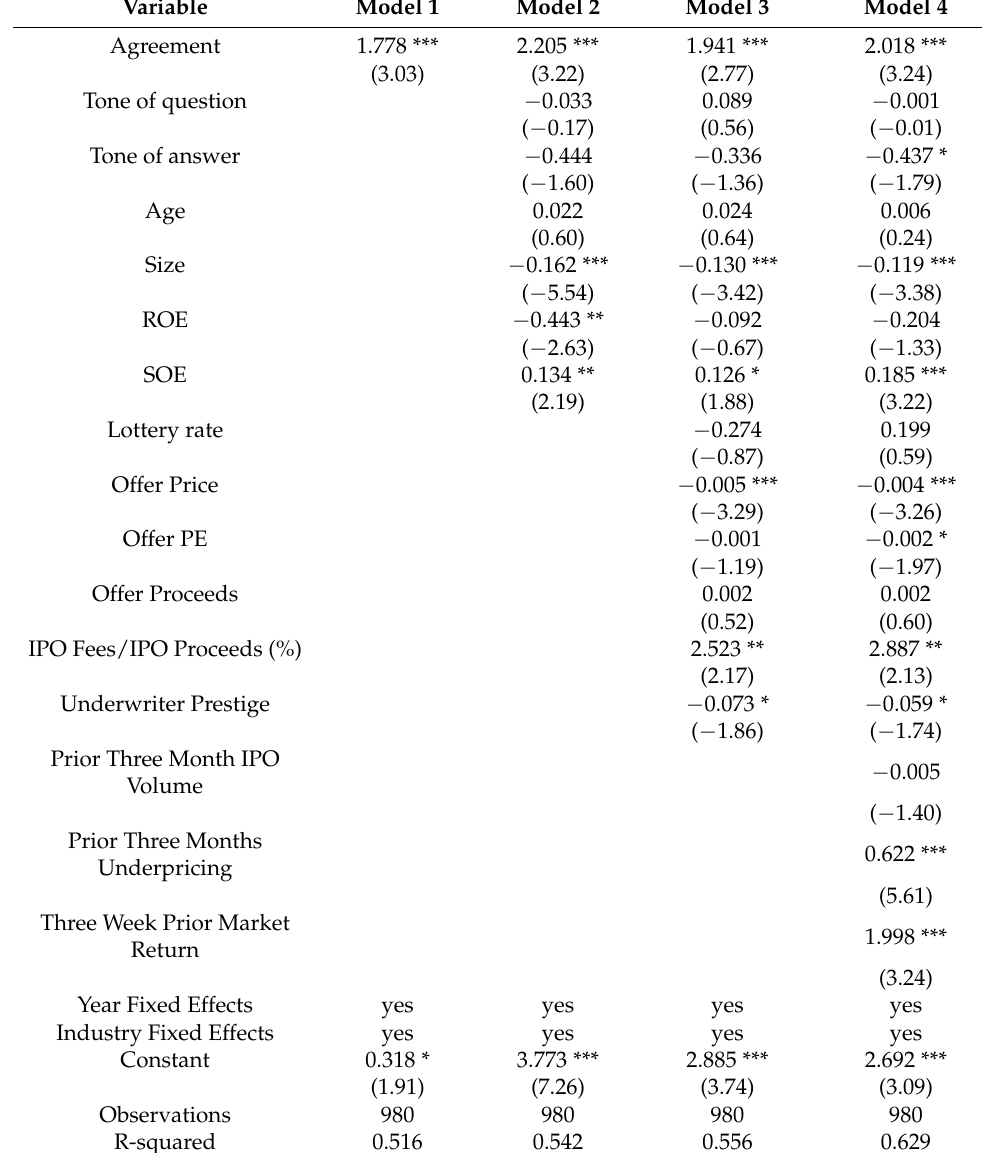
Table 4. Agreement and